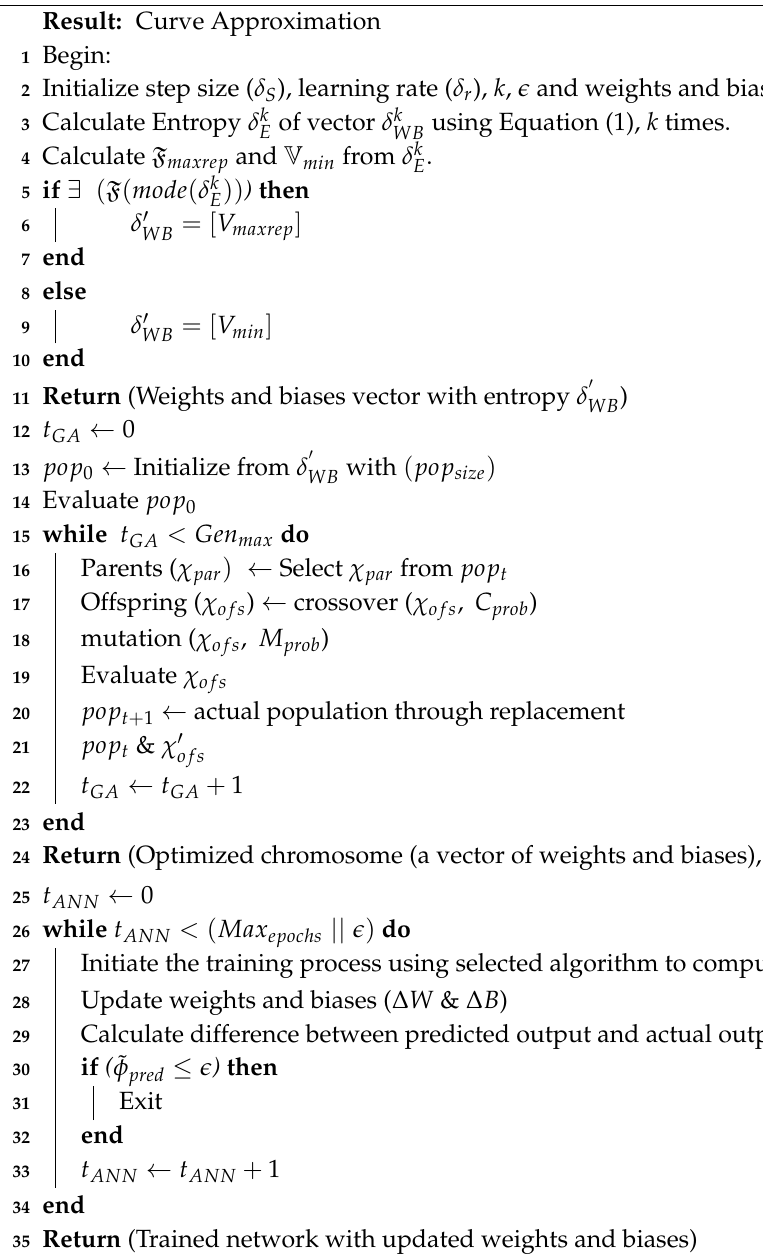
Algorithm 1: Entropy based GA for weights and biases